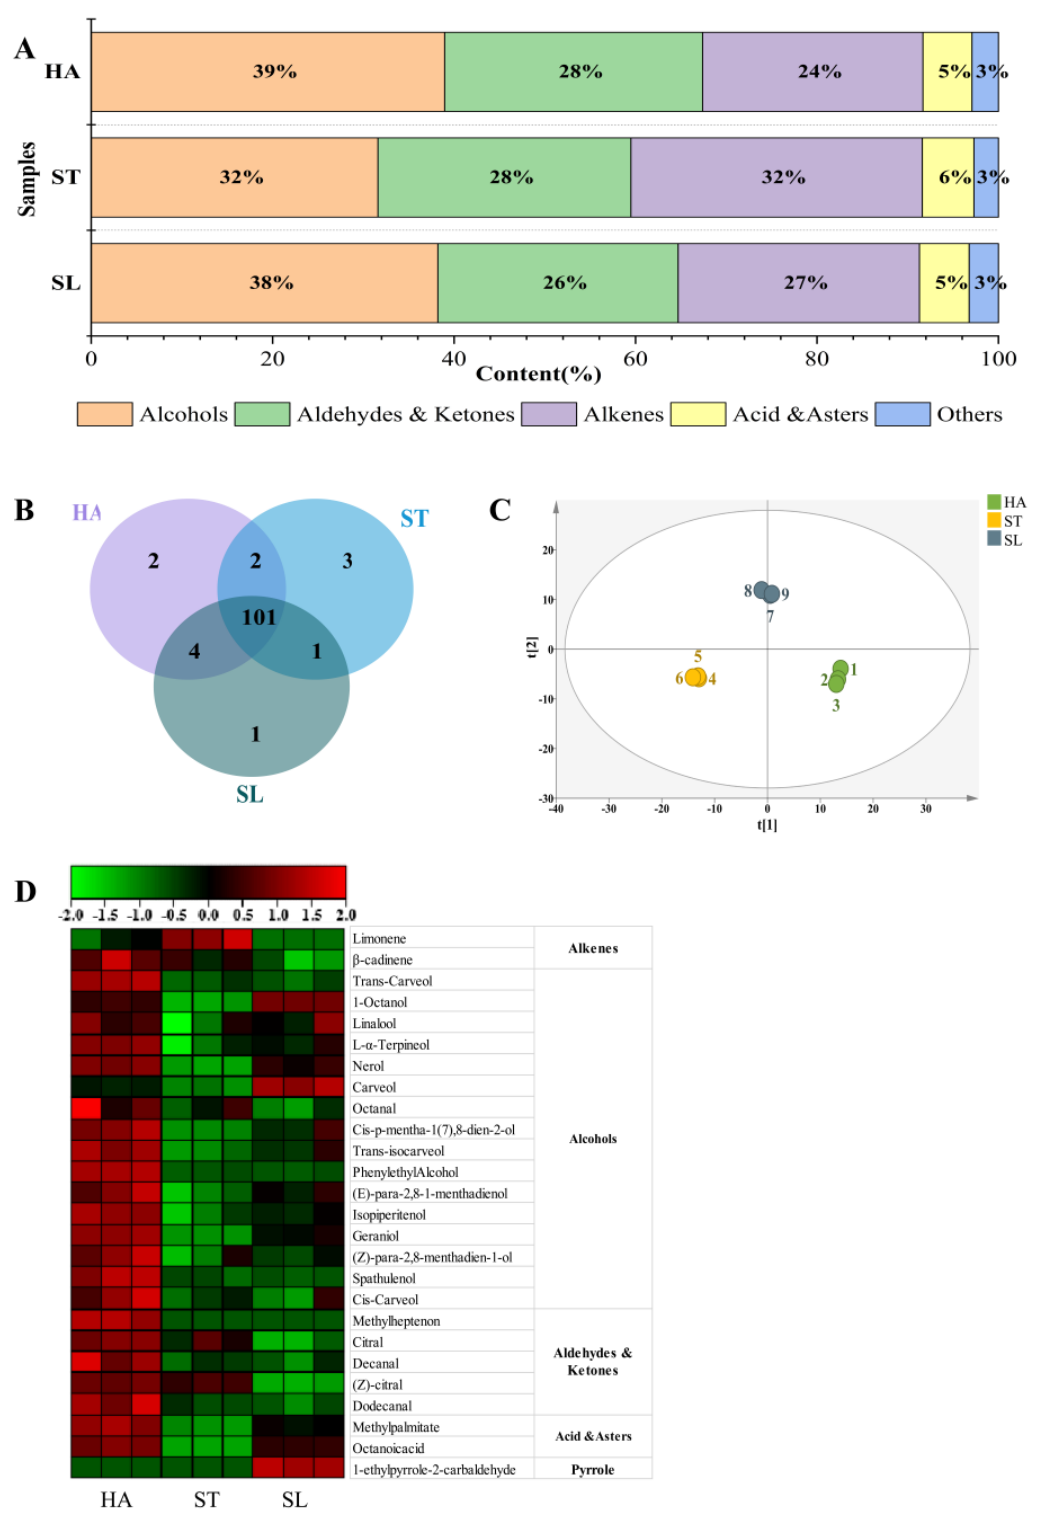
Figure 3. Effects of different fixing methods on the content of volatile compounds in orange dark tea. ( A ) Main volatile components in differently fixed ODTs; ( B ) Venn diagram of volatile compounds in differently fixed ODTs; ( C ) OPLS-DA score plot (R 2 Y = 0.996, Q 2 = 0.966). ( D ) Heat-map for the main volatile compounds in differently fixed dark orange teas. Table 2. Analysis of volatile components in orange dark tea with different fixing methods ( μg/ g) .